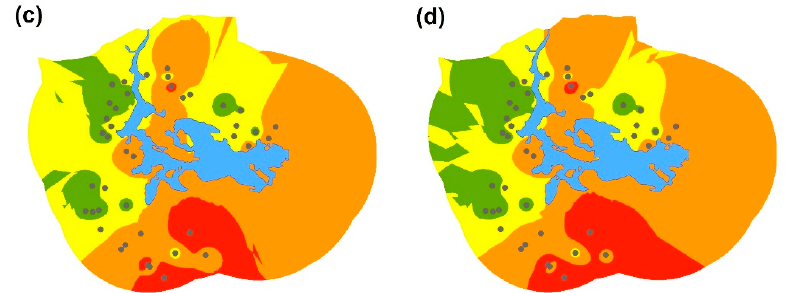
Figure 4. Distribution of irrigation water quality classes based on electrical conductivity during the dry season: ( a ) March, ( b ) April, ( c ) May, and ( d ) June, based on Food and Agriculture Organization of the United Nations irrigation water quality guidelines [29].